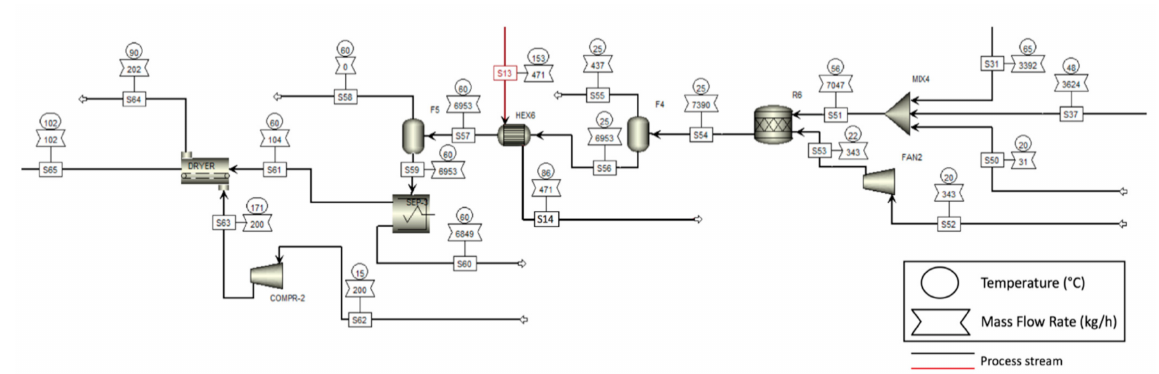
Figure 3. Flowsheet of lipid production as simulated using Aspen